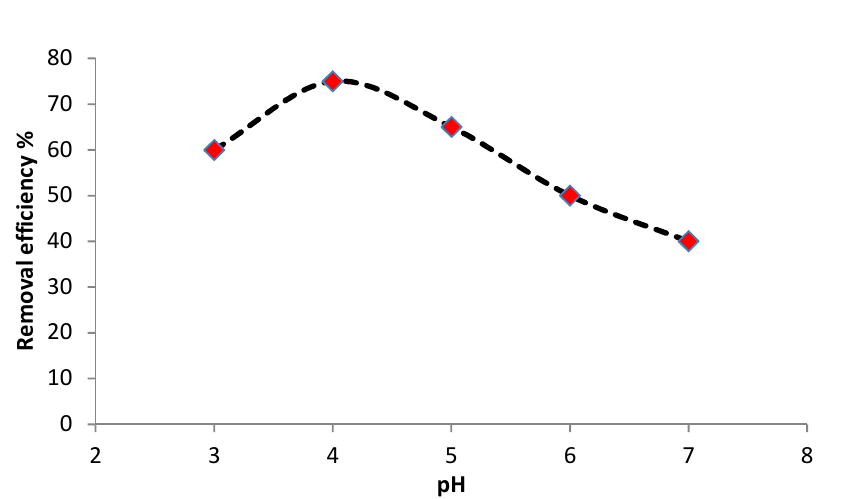
Figure 1. Effect of pH on uptake capacities of arsenate ions using chitosan